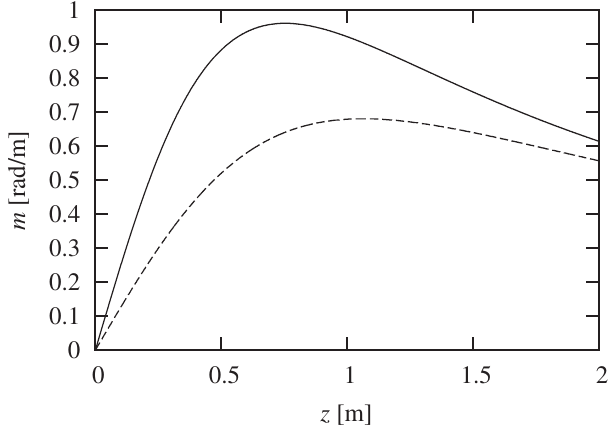
FIG. 4. Development of the slopes of the phase space ellipses corresponding to Fig. 3 (only numerical results) for the case with P ¼ 10 − 5 (solid line) and P ¼ 5 × 10 − 6 (broken line). Close to the maxima of the slopes, also the difference between the slopes is maximal. Further downstream, the spread reduces again.